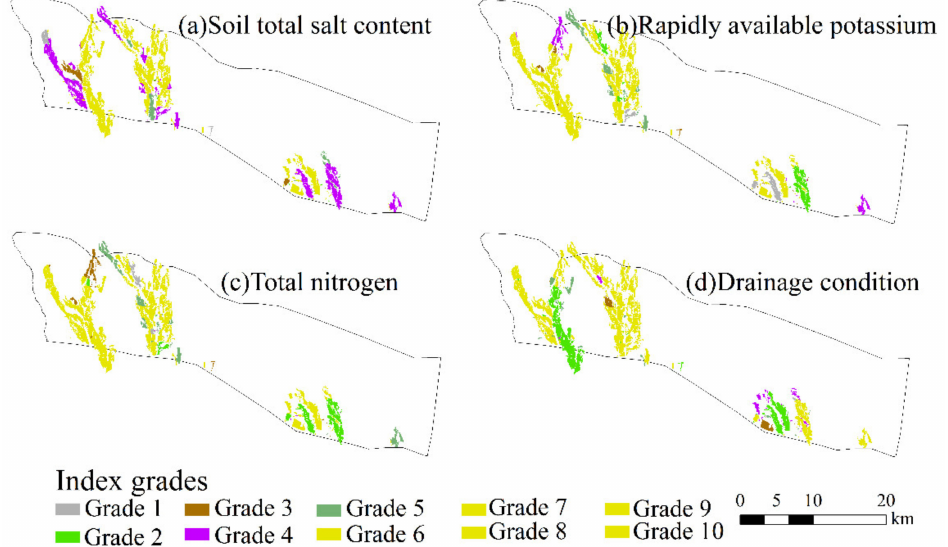
Figure 9. Spatial distribution of the influential factors at the lower part of the diluvial fan. ( a ) Soil total salt content, ( b ) Rapidly available potassium, ( c ) Total nitrogen, and ( d ) Drainage